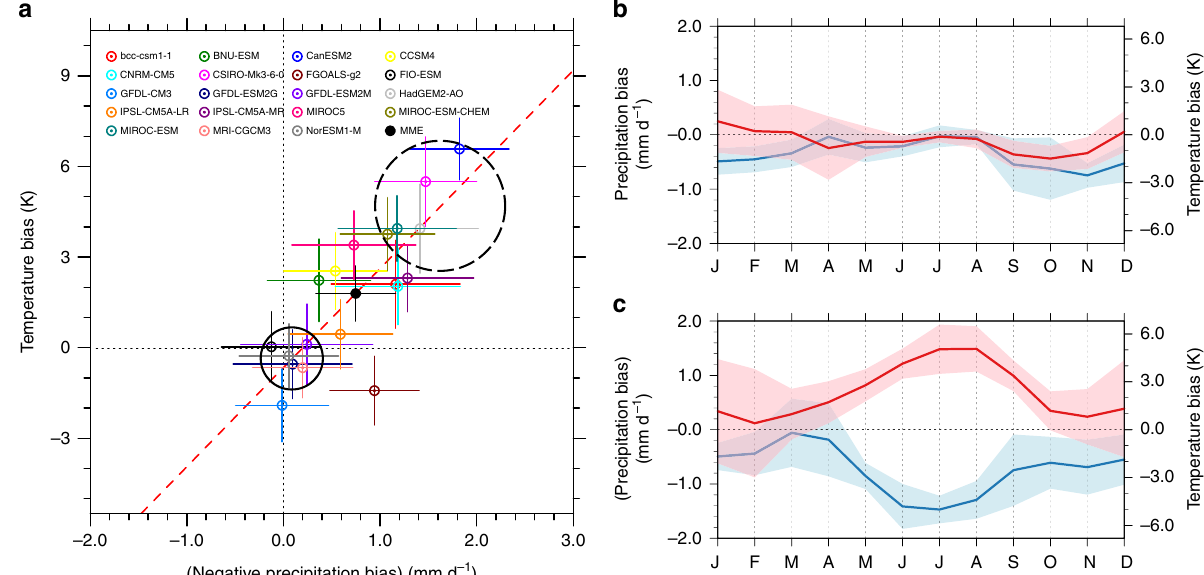
Fig. 2 Characteristics of temperature bias and precipitation bias. a Scatter plot of the summertime temperature bias and precipitation bias over the central U.S. from 19 CMIP5 historical simulations during the reference period 1979 – 2005. Solid dot indicates the multi-model mean while horizontal and vertical colored lines indicate one standard deviation The red dash line indicates the least-square linear fi t among the models. The solid (dash) circle contains the models selected as good (bad) group. b Seasonal evolution of temperature and precipitation biases for the good group. c Same as b but for the bad group. The blue lines in b , c use the left y -axes, indicating precipitation, while the red lines use the right y -axes, indicating temperature. Shaded regions in b , c indicate one standard